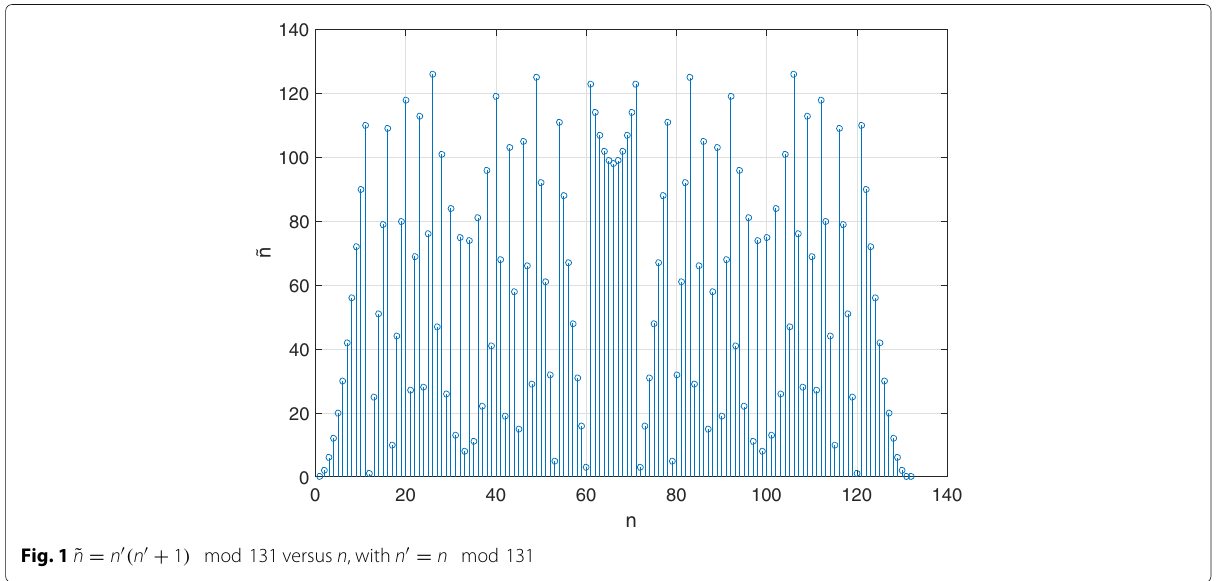
Fig. 1 ˜ n = n (cid:6) ( n (cid:6) + 1 ) mod 131 versus n , with n (cid:6) = n mod 131